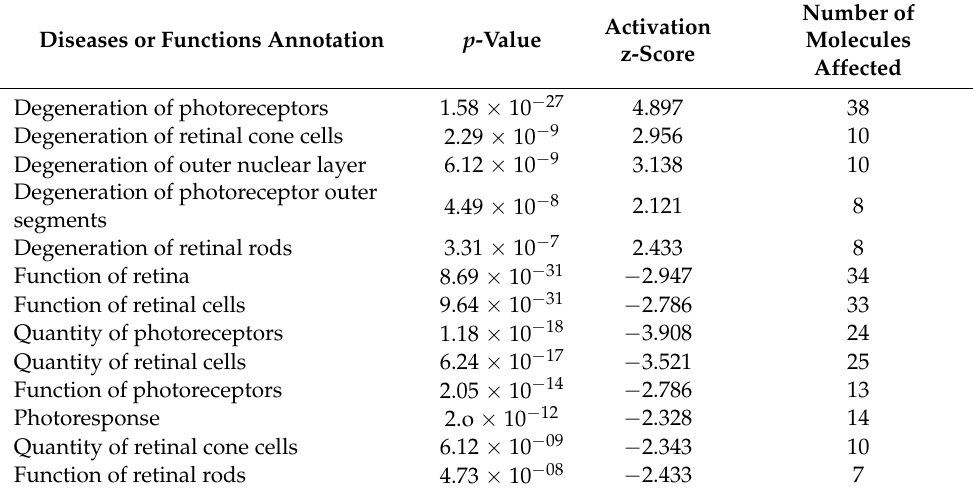
Diseases or Functions Annotation p